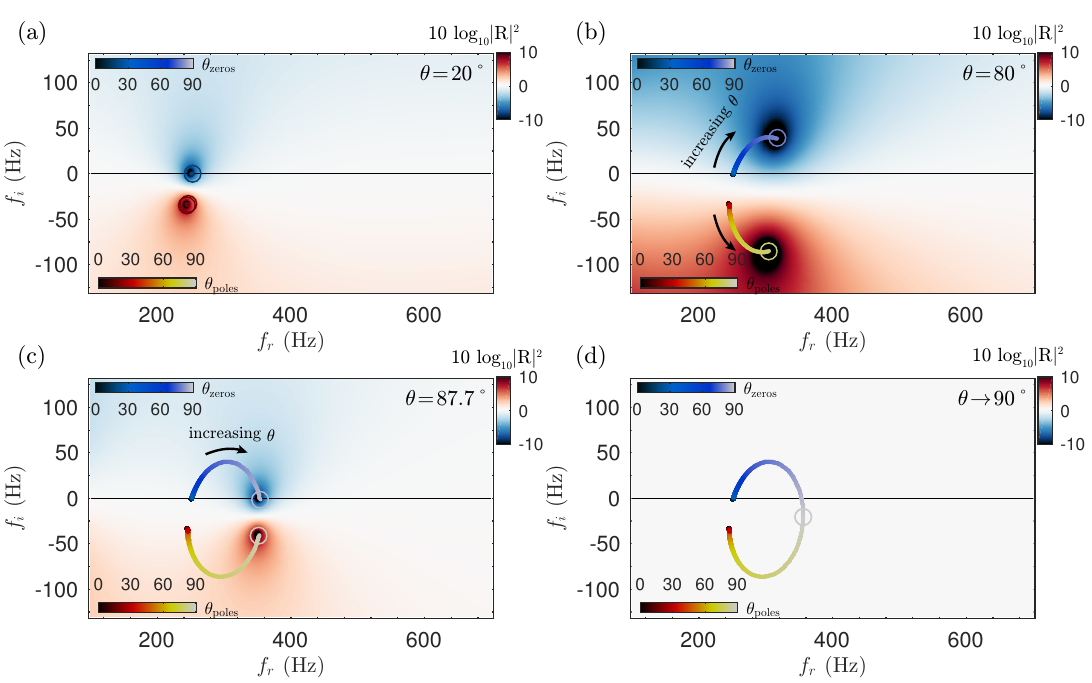
Figure 3. Complex frequency representation of the reflection coefficient for the metamaterial with N = 1 HR, in logarithmic colour scale, for different angles of incidence. ( a ) θ = 20 ◦ ; ( b ) θ = 80 ◦ ; ( c ) θ = 87.7 ◦ ; ( d ) θ → 90 ◦ . The trajectories of the poles and the zeros of the reflection coefficient as the incidence angle is increased are plotted in coloured lines, corresponding to the blueish and reddish colour bars,